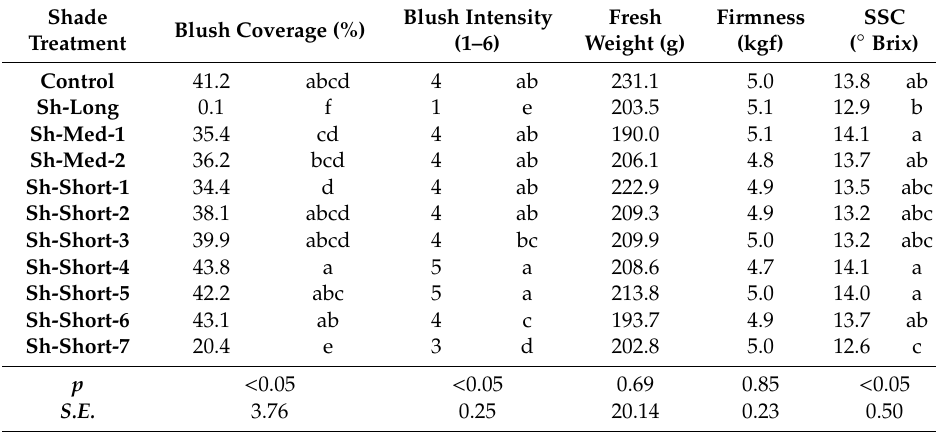
Table 2. Means of harvest fruit quality parameters of all treatments in the “ANP-0131”. Letters indicate means separation by Fisher’s LSD ( α = 0.05). Probability value ( p ) and the standard error of the means (S.E.) are